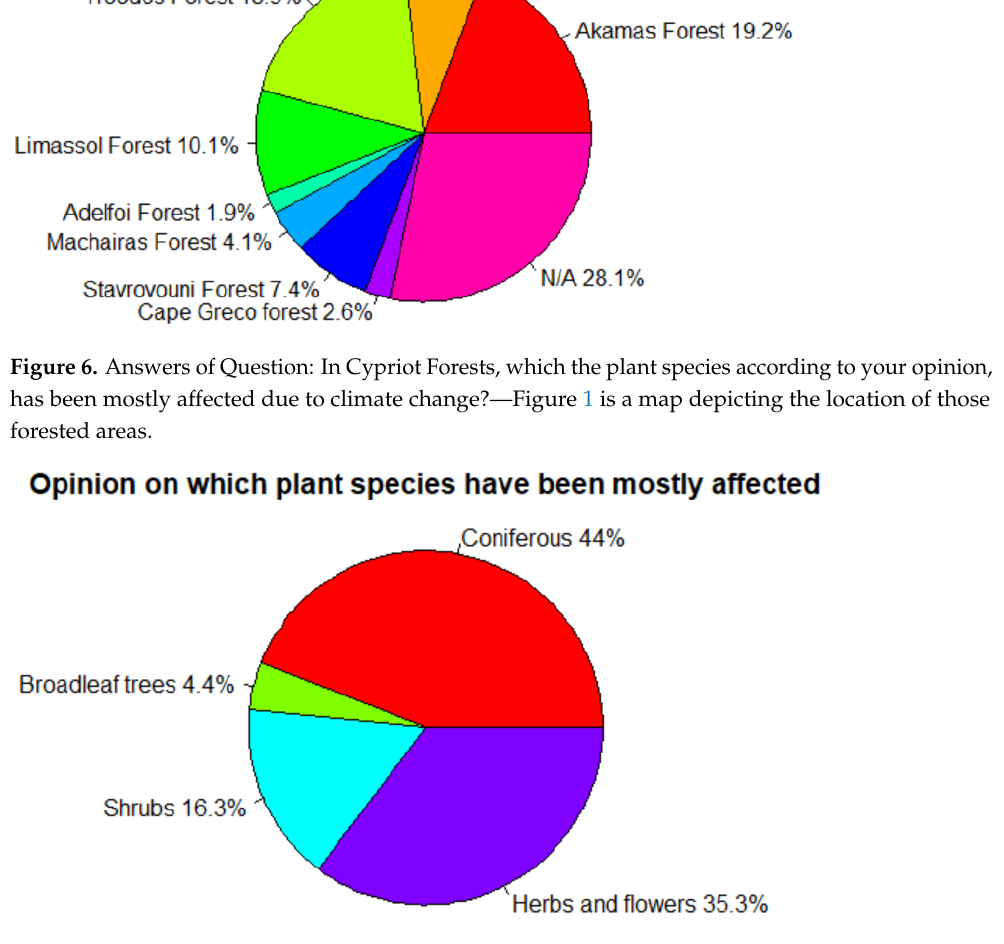
Figure 7. Answers of Question: In Cypriot Forests, which the plant species according to your opinion, has been mostly affected due to climate change? (no “N/A” option was